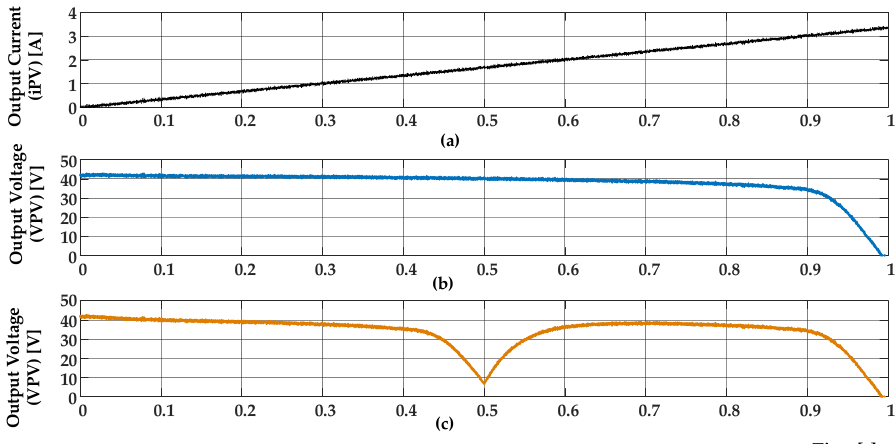
Figure 9. Simulation results considering the system operating in mode I (test panel mode): ( a ) continuous load variation with output current increasing; ( b ) output voltage variation with load variation considering a fixed G = 1000 W/m 2 and T S = 25 ◦ C; ( c ) output voltage variation with load variation initial with G = 600 W/m 2 and step to G = 1000 W/m 2 at t = 0.5 s.